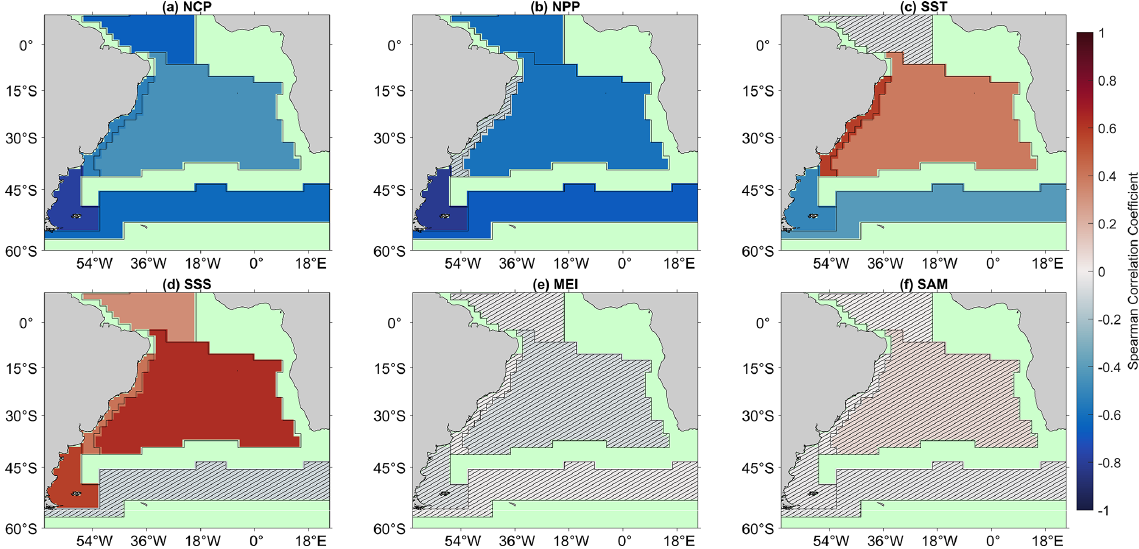
Figure A1. Spearman correlations between the in situ (cid:49)p CO 2 seasonal component of the X-11 analysis and (a) net community production (NCP), (b) net primary production (NPP), (c) sea surface temperature (SST), (d) sea surface salinity (SSS), (e) multivariate ENSO index (MEI), and (f) Southern Annular Mode (SAM) seasonal components on a per province basis. Hashed areas indicate no significant correlations, and green regions indicate no analysis was performed due to missing data.